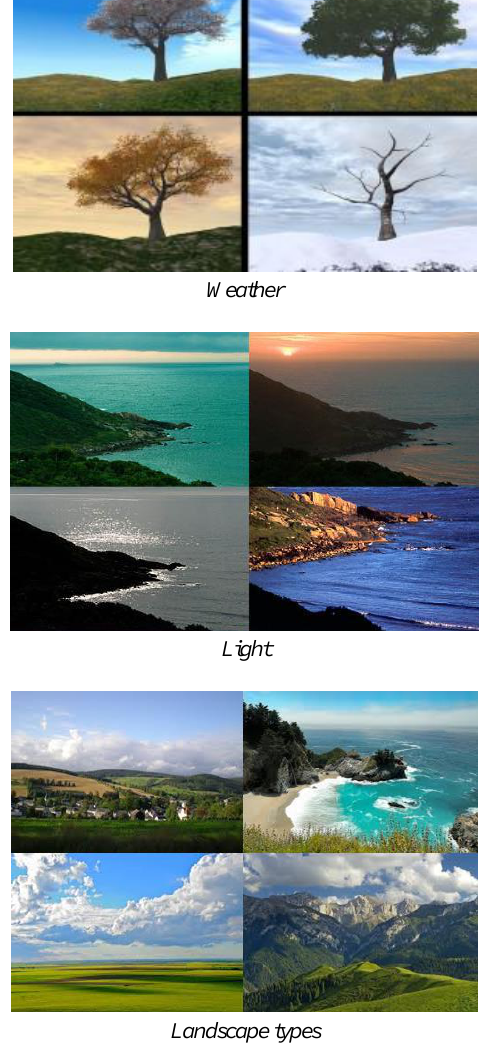
Figure 1. Some of different environmental condition when